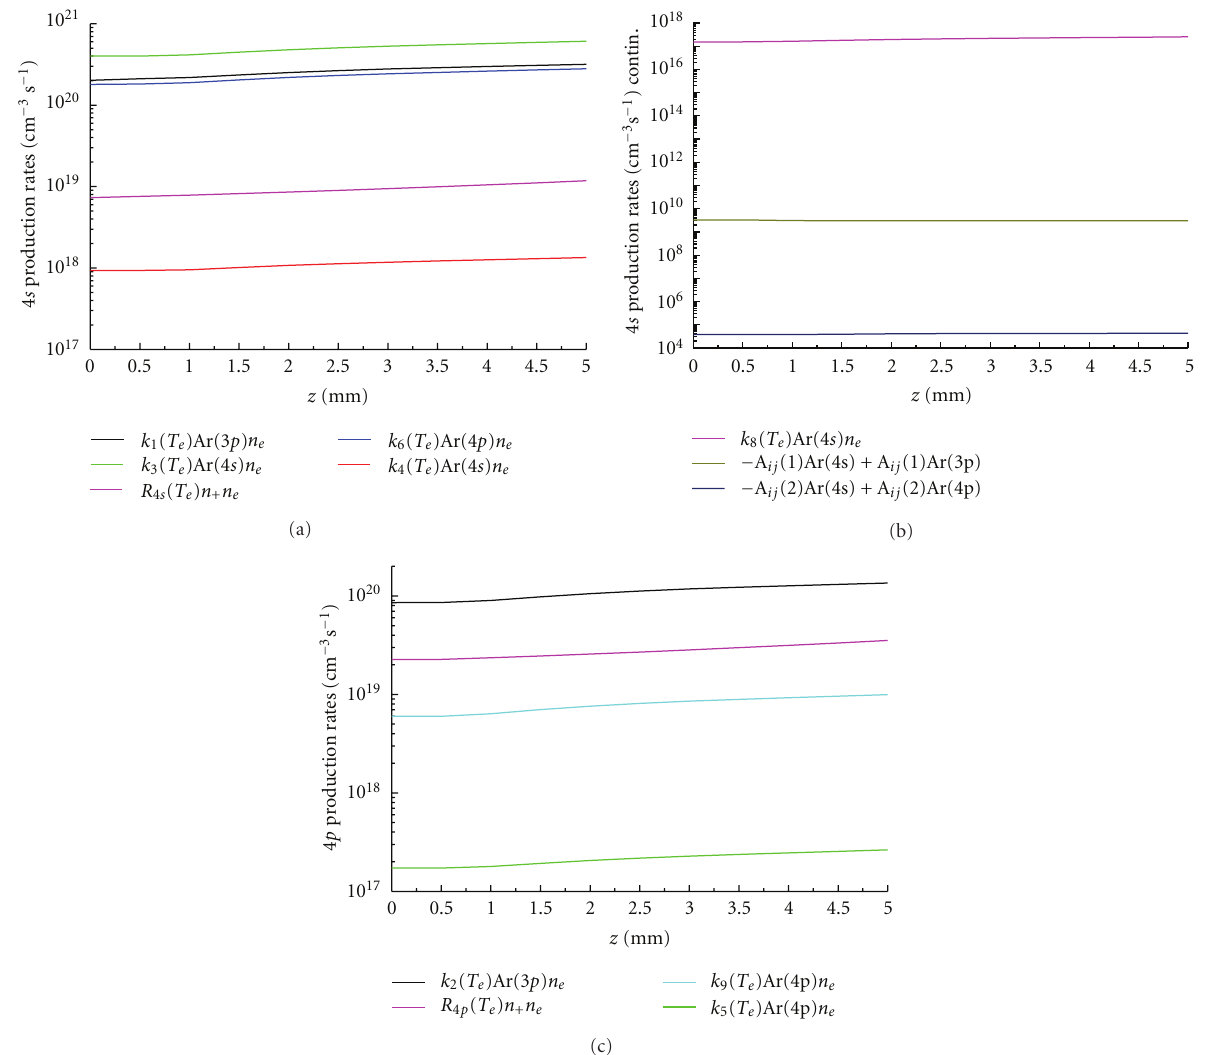
Figure 13: Production rates of Ar(4 s ) and Ar(4 p ) along the throat axis for I =